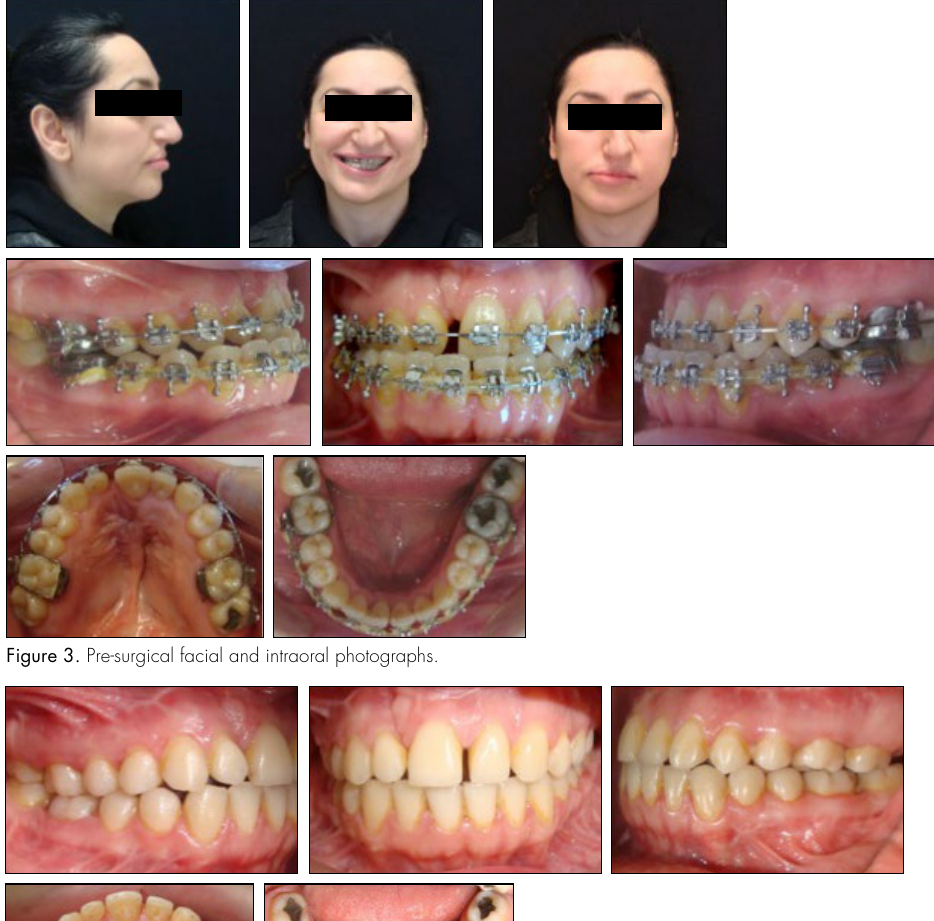
Figure 4. Post-treatment intraoral photographs before reshaping